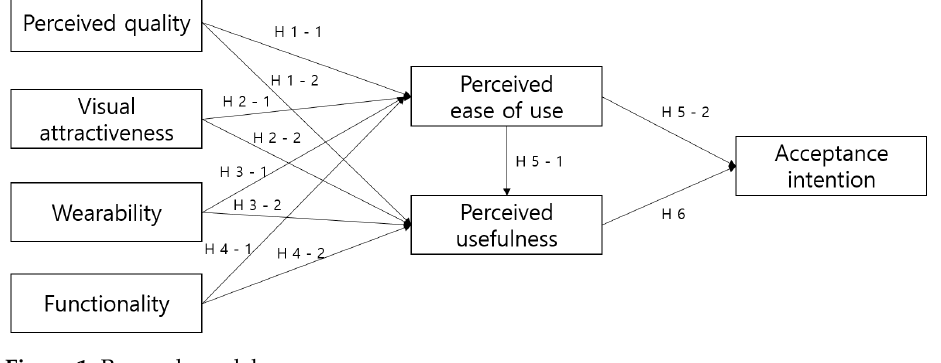
Figure 1. Research model.